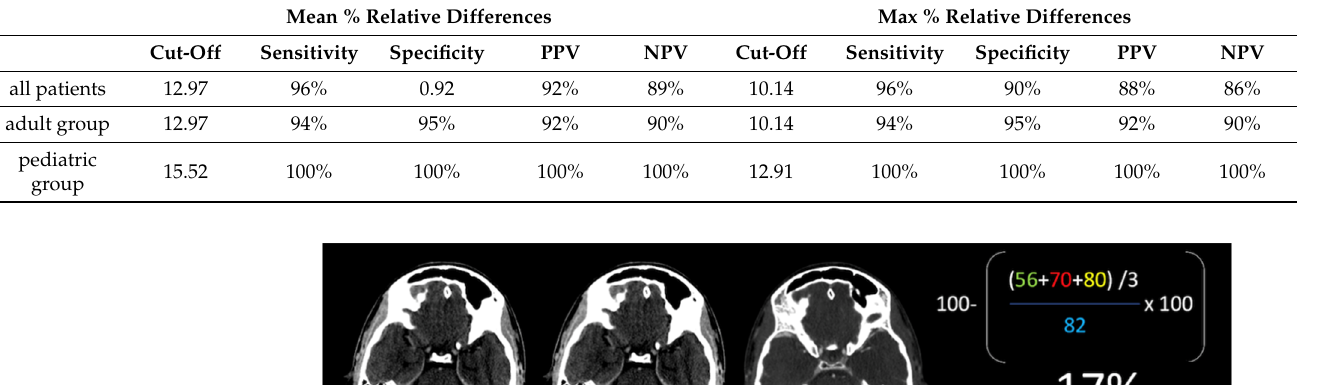
Table 2. Optimized cut-off for distinguish patients with and without cerebral venous sinus throm- bosis. The second and third rows show analysis in the adult and pediatric subgroups, respectively. PPV = positive predictive value; and NPV = negative predictive value.